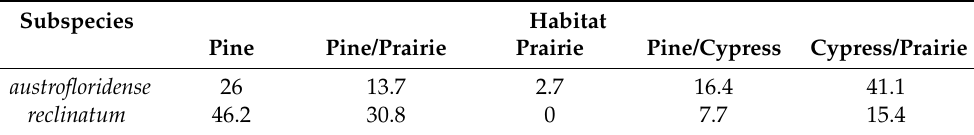
Table 1. Habitats in which Sideroxylon reclinatum s.l. specimens that were identified to subspecies were found using the percentage of each taxon’s conclusive occurrences. Habitats with a “/” represent ecotonal, or mixed associations. The table represents a rough gradient of increasing hydroperiod from left to